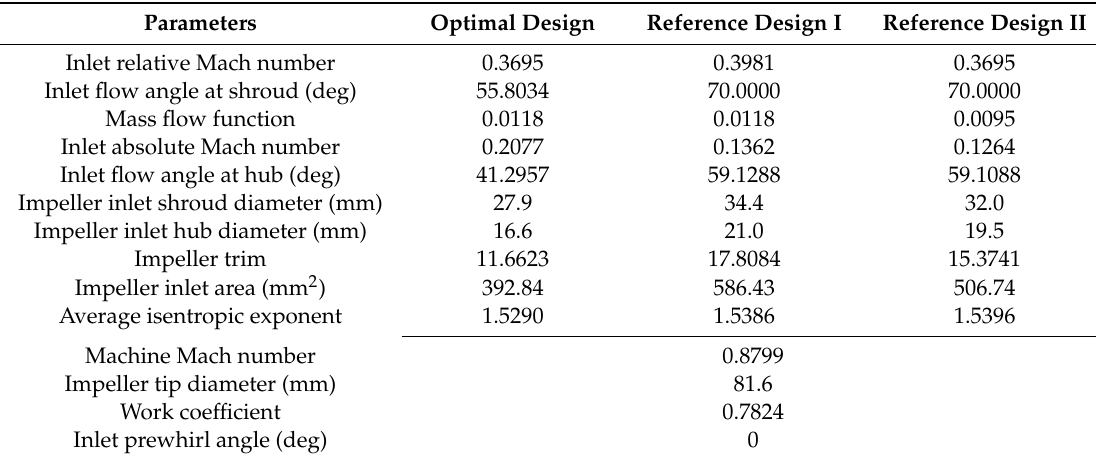
Table 5. Preliminary design parameters of the three design schemes: Optimal Design, Reference Design I, and Reference Design